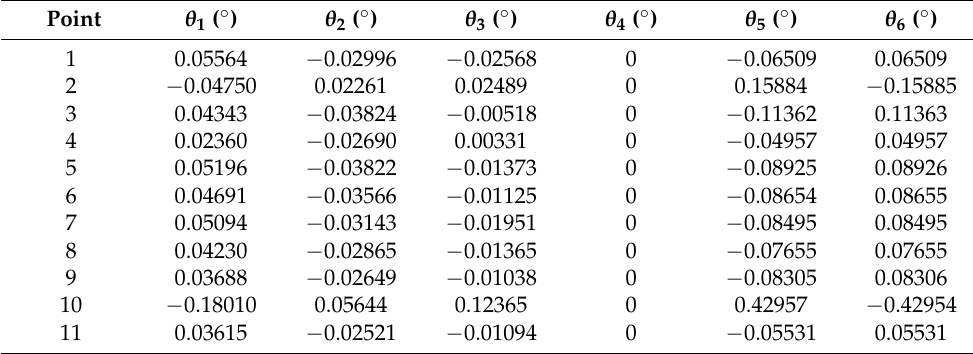
Table 2. Compensated joint angles ∆ q (under 10.6